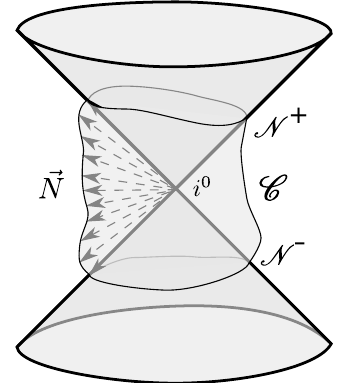
Figure 2 . The space C of null and spatial directions ~N at i 0 . The boundaries N ± ∼ = S 2 , diffeomorphic to the space of generators of I ± respectively, represent the space of null directions. C \ N ± is the space of rescaled spatial directions conformally diffeomorphic to the unit-hyperboloid H . C depends on the choice of the rescaling function Σ (defined below) and need not be a cylinder of unit radius in Ti 0 — we have drawn a “wiggly” cylinder to emphasise